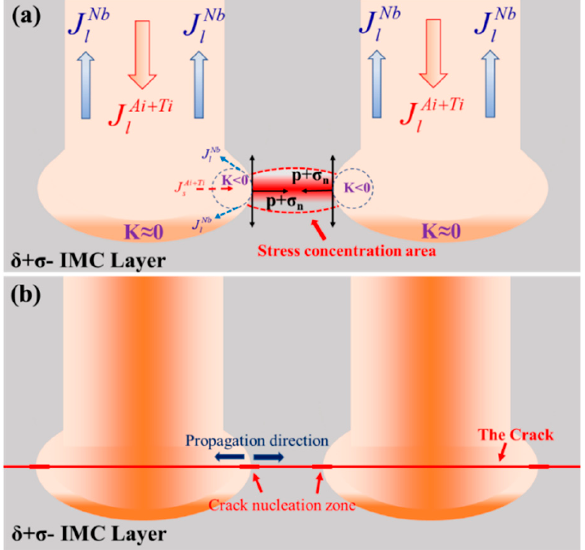
Figure 15. Stress interaction near the blunted U-groove tip and crack propagation: ( a ) the related stress interactions coupled with element diffusion, ( b ) schematic illustration of crack nucleation and propagation.